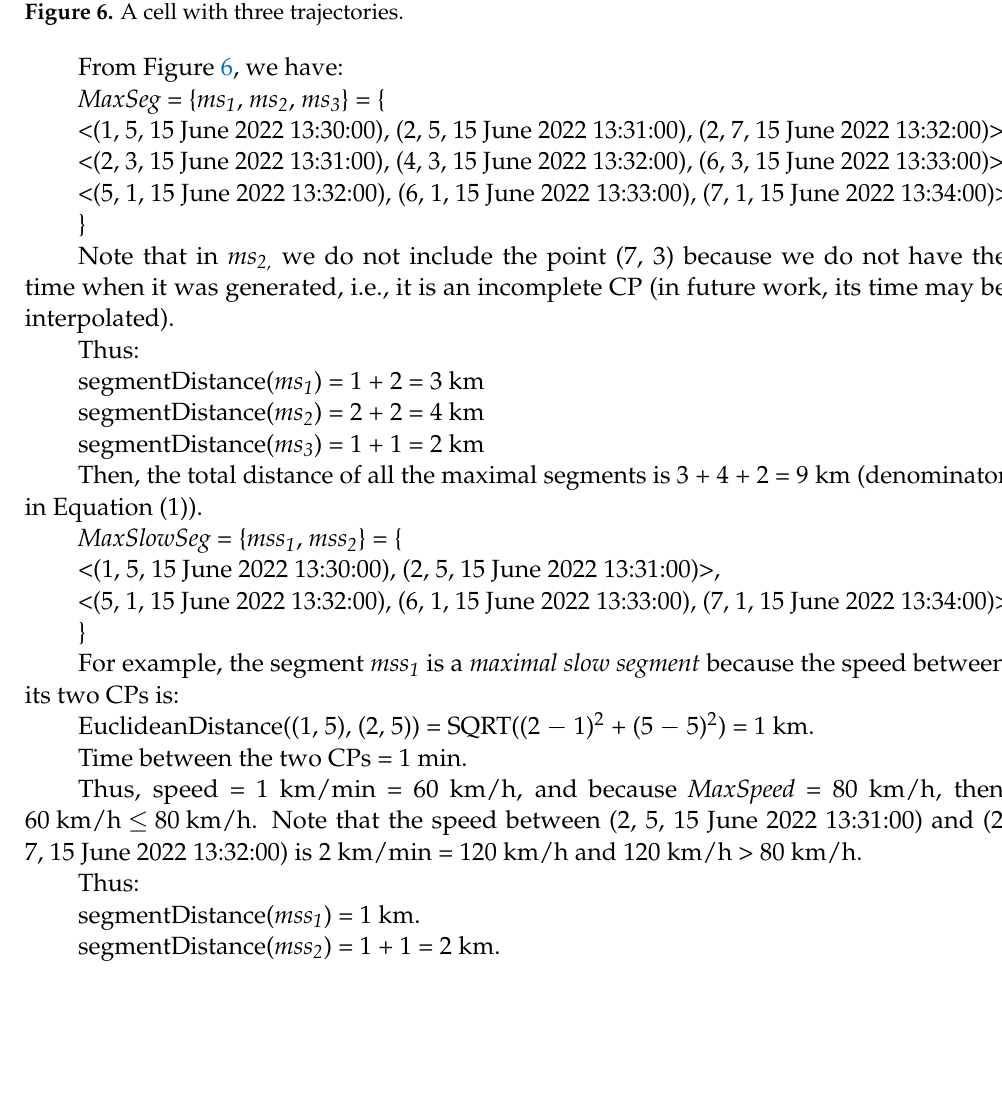
Figure 6. A cell with three